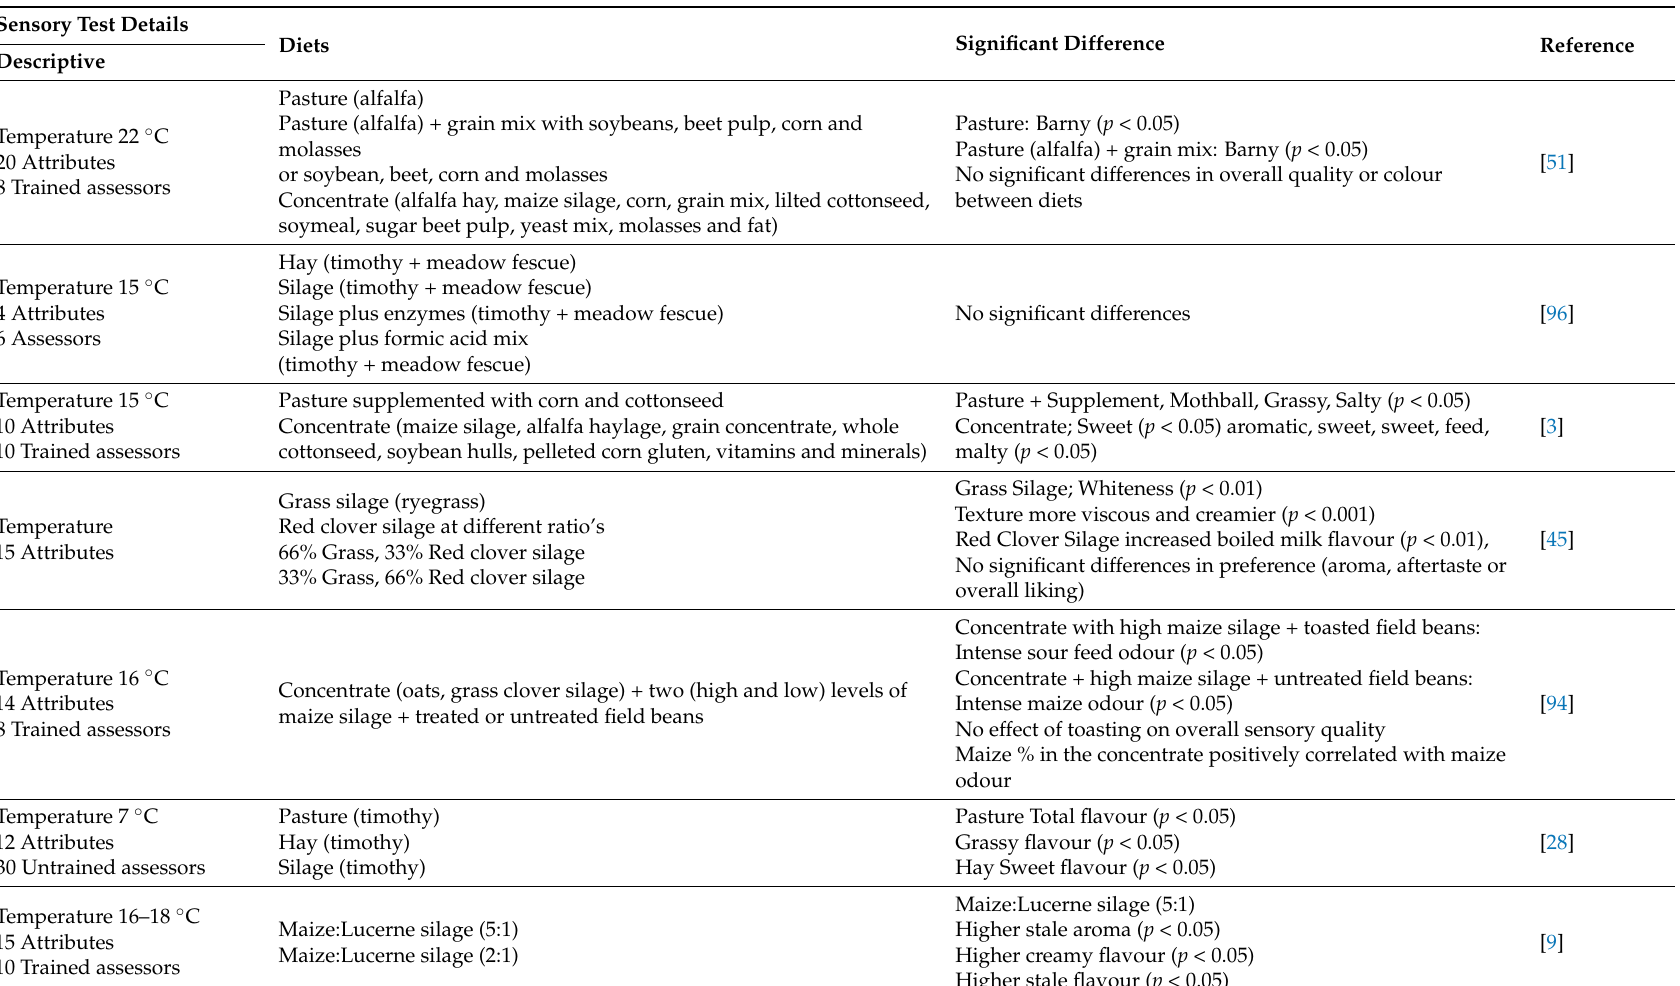
Table 3. Summary of sensory analysis studies of pasteurized bovine